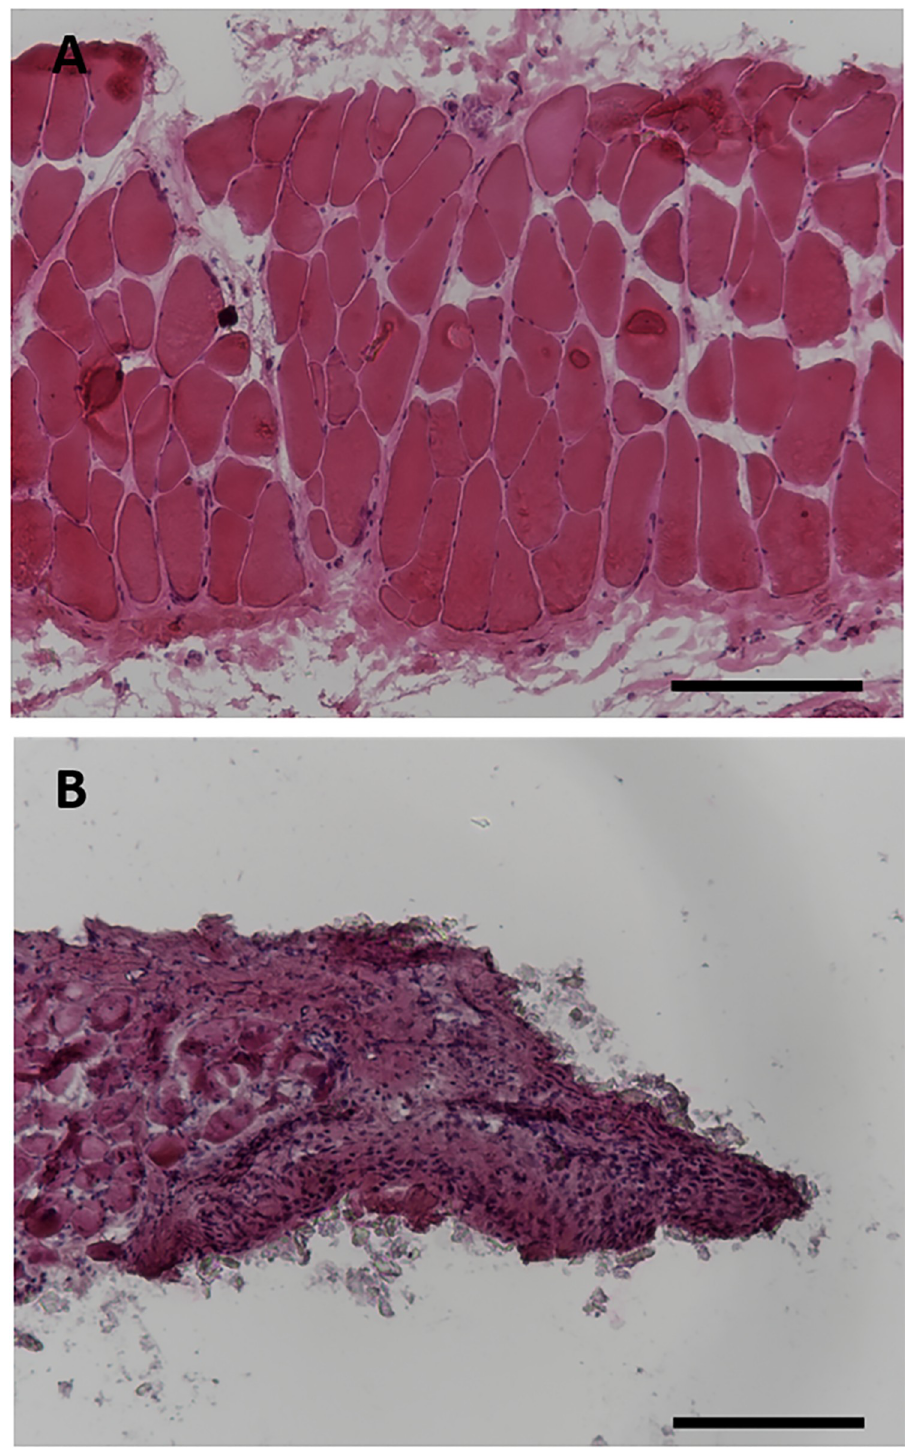
Fig 1. Histology of hematoxylin and eosin-stained rat latissimus dorsi skeletal muscle shows the cross-section of healthy muscle (A) and the cross-section 7 days after VML injury (B). The lack of muscle fibers on the right half of the image marks the defect caused by the VML injury. Scale bars = 200 μ